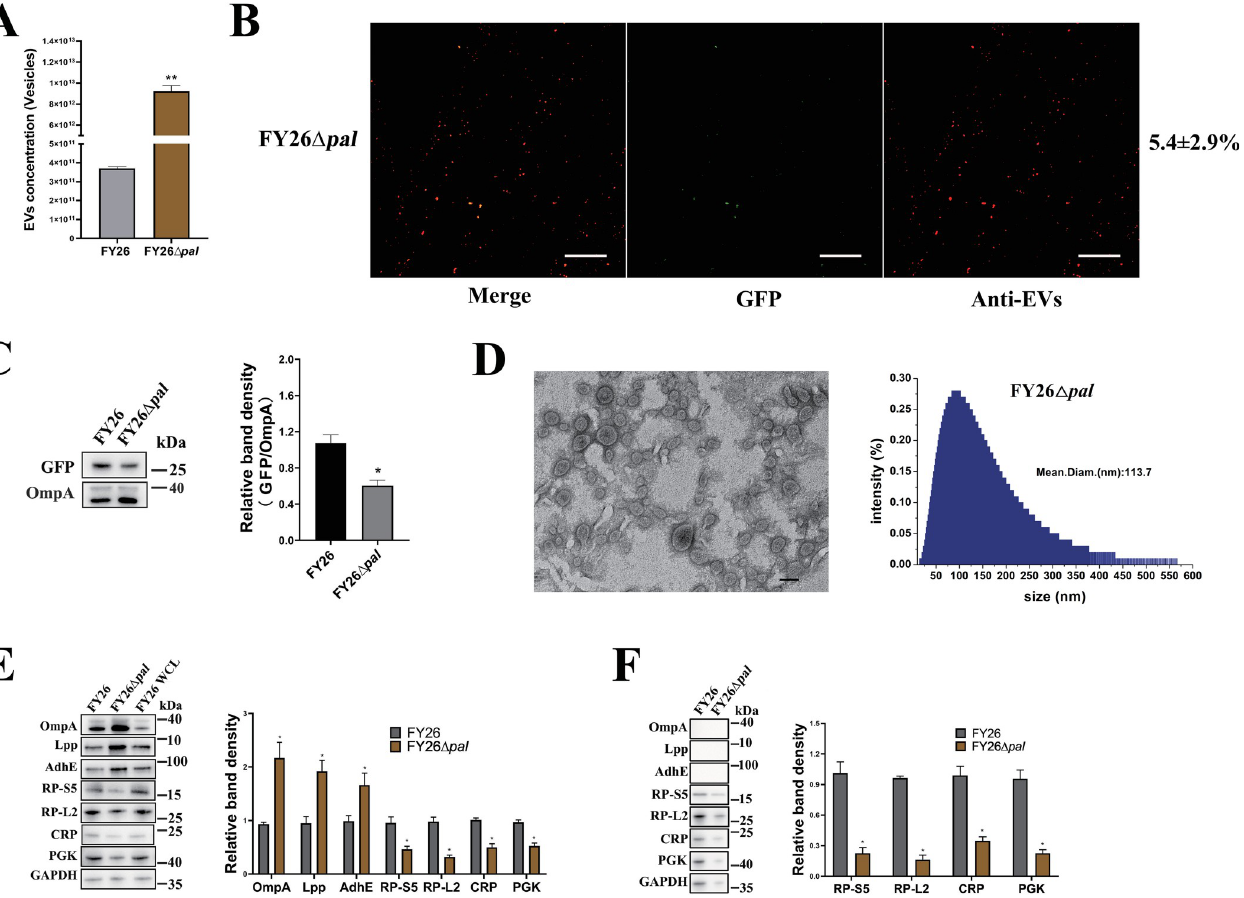
Fig 6. Deletion of pal gene affects the production of ExPEC outer-membrane vesicles (OMVs). (A) The concentrations of purified EVs produced by FY26 and FY26 Δ Pal were determined with a nanoparticle tracking analysis (NTA). (B) Immunofluorescent detection of EVs produced by FY26 Δ pal . The percentage of GFP-carrying vesicles (green fluorescence) is indicated on the right. Data were obtained from at least three independent experiments, with three replicates. Graph shows a representative image. Scale bars: 10 μ m. (C) GFP and OmpA proteins in EVs were determined with western blotting. (D) The EVs produced by FY26 Δ Pal were observed with transmission electron microscopy (TEM), and the size distributions of the purified EVs were detected with Dynamic light scattering (DLS). Scale bars: 200 nm. (E) Levels of membrane and cytoplasmic proteins in EVs from FY26 and FY26 Δ pal were determined with western blotting. (F) Levels of membrane and cytoplasmic proteins in EV-free extracellular medium of FY26 and FY26 Δ pal were determined with western blotting.